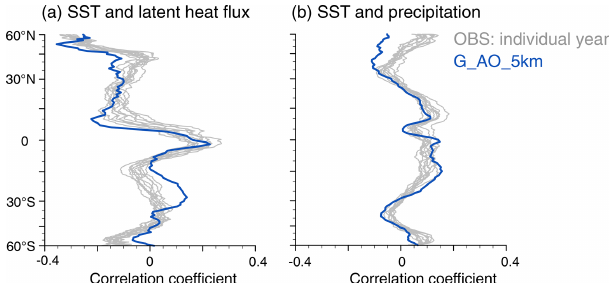
Figure 8. Meridional cross-section of zonally averaged correlation between SST and (a) latent heat flux and between SST and (b) precipitation. Observed SST from the Optimum Interpolation SST (OISST, grid spacing 0.25 ◦ , Reynolds et al., 2018), latent heat flux from the Objectively Analyzed air–sea flux (OAFlux_V3, grid spac- ing 1 ◦ ), and precipitation from the Integrated Multi-satellitE Re- trievals for Global Precipitation Measurement (IMERG, grid spac- ing 0.1 ◦ ). Daily values are